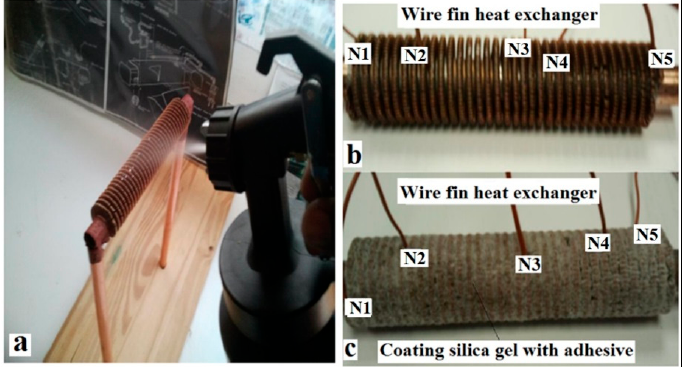
Table 1. Specification for the copper wire woven